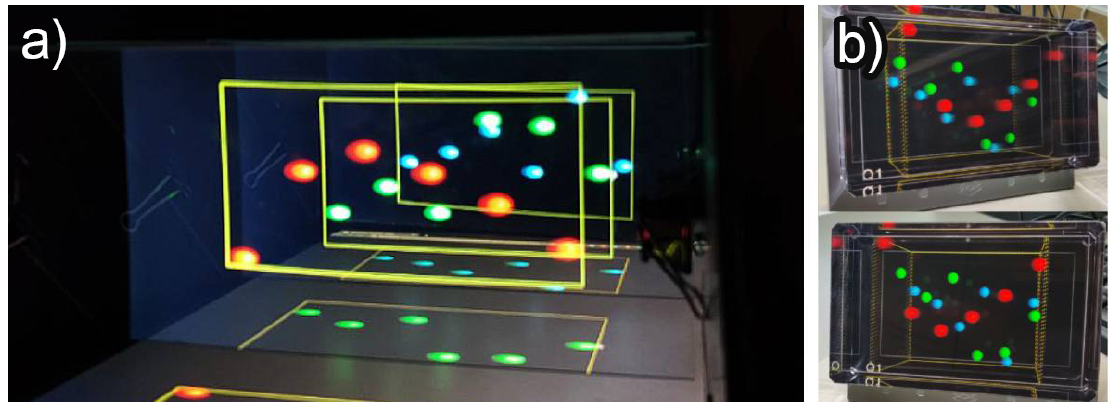
Figure 8. ( a ) 3D chart task on a SliceView device. ( b ) On a LookingGlass device observed from two different angles.